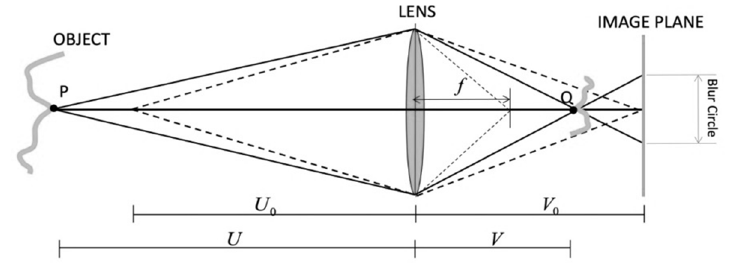
Figure 1. Focusing geometry of the imaging